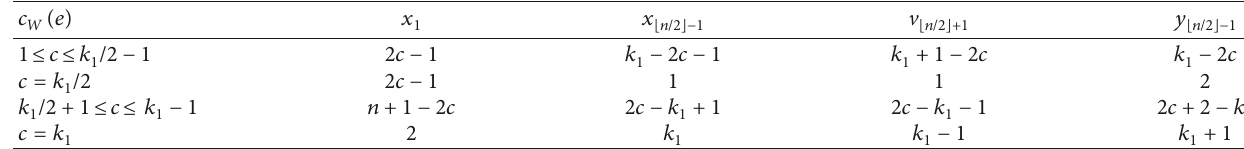
u c is even. c c , when